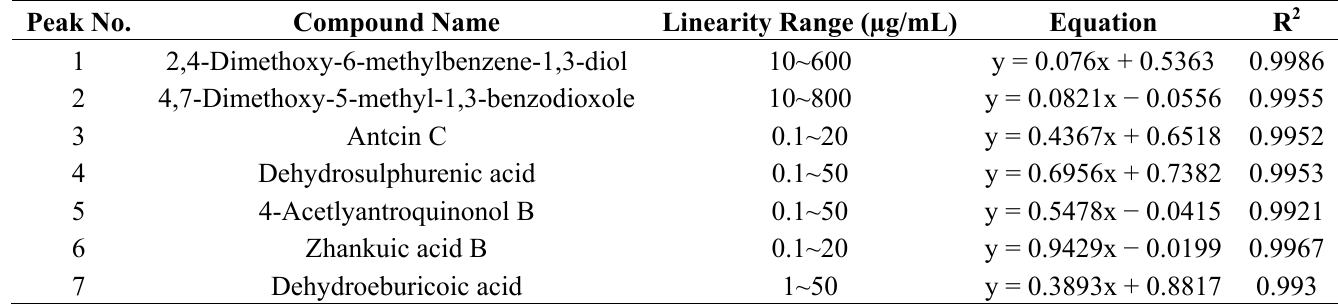
Table 3. Calibration curves of three benzenoids and four triterpenoids in solid-state cultured mycelia of Antrodia cinnamomea determined by